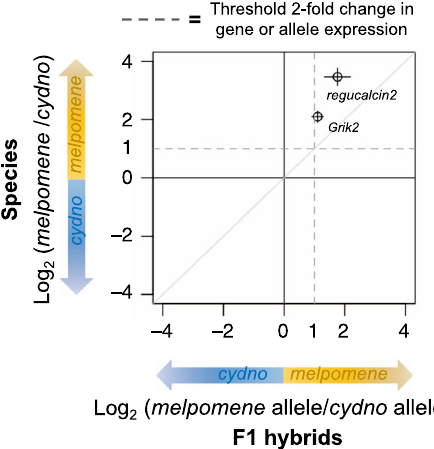
Fig. 3 Grik2 and regucalcin2 show evidence of allele-speci fi c expression. Points indicate the mean value, and bars the standard error, of the (base 2) logarithmic fold change in expression between parental species (vertical) ( n = 23 biologically independent samples) and the alleles in F1 hybrids (horizontal) ( n = 10 biologically independent samples), for candidate genes (as de fi ned in the transcript-guided annotation). Dashed lines indicate the threshold for a twofold change in expression for the genes in the species (horizontal), and for the alleles in the hybrids (vertical). Both genes seem to be regulated by a combination of cis - and trans -acting factors, rather than cis -acting factors alone (which would be indicated by y = x